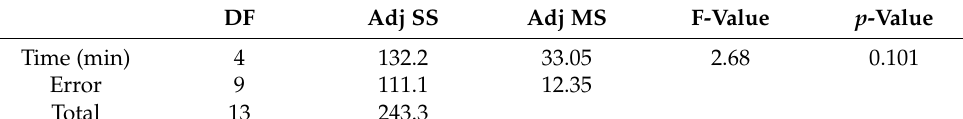
Figure 2. Peak area of fructose (nA × min) versus extraction time (min). Table 1. Analysis of variance for the effect of extraction time on the fructose stability.